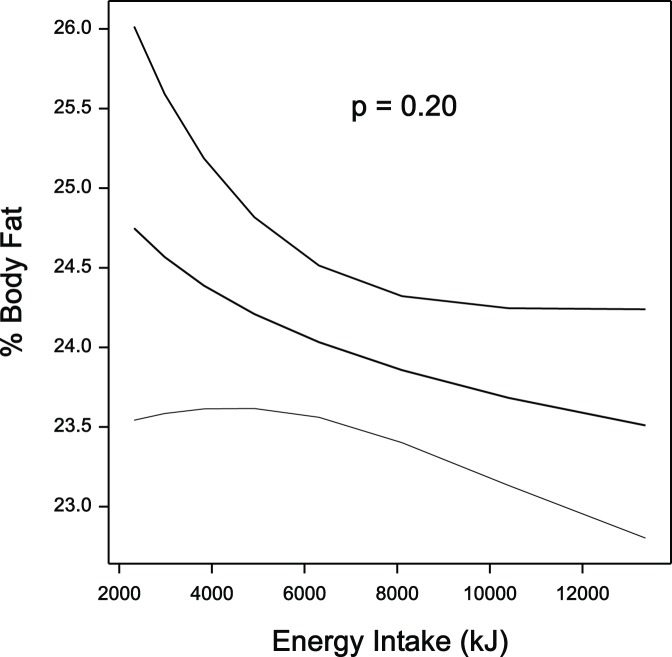
The cross-section relationship, with 95% confidence intervals, between %BF and total energy intake (approximately the square root of average number of steps per day) for boys and girls, combining data from both measurement periods.